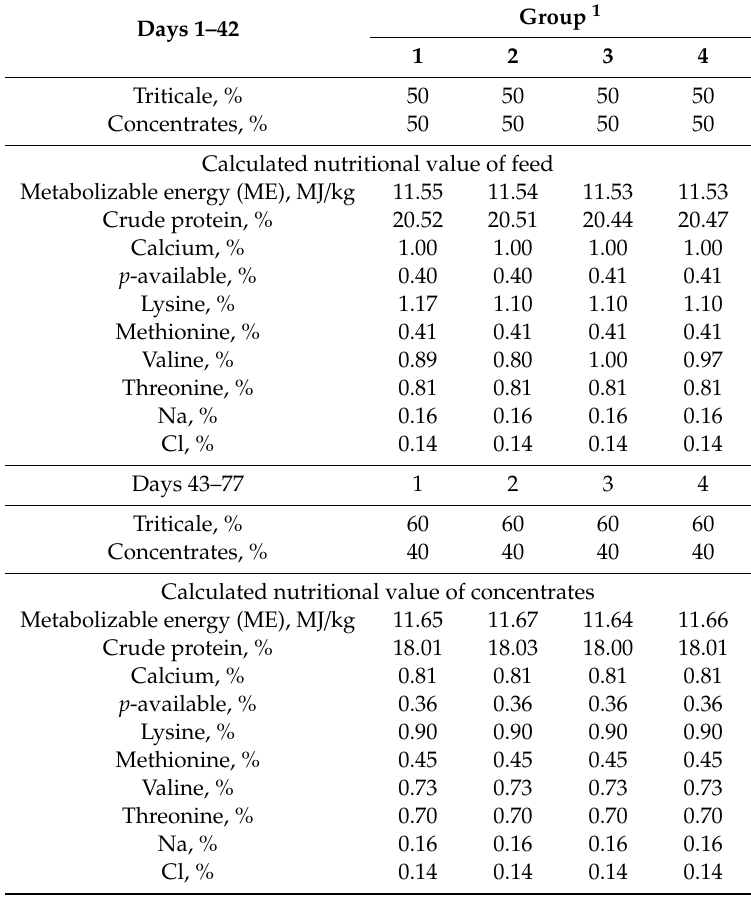
Table 2. Composition of feed used during a 77-day rearing period of broiler